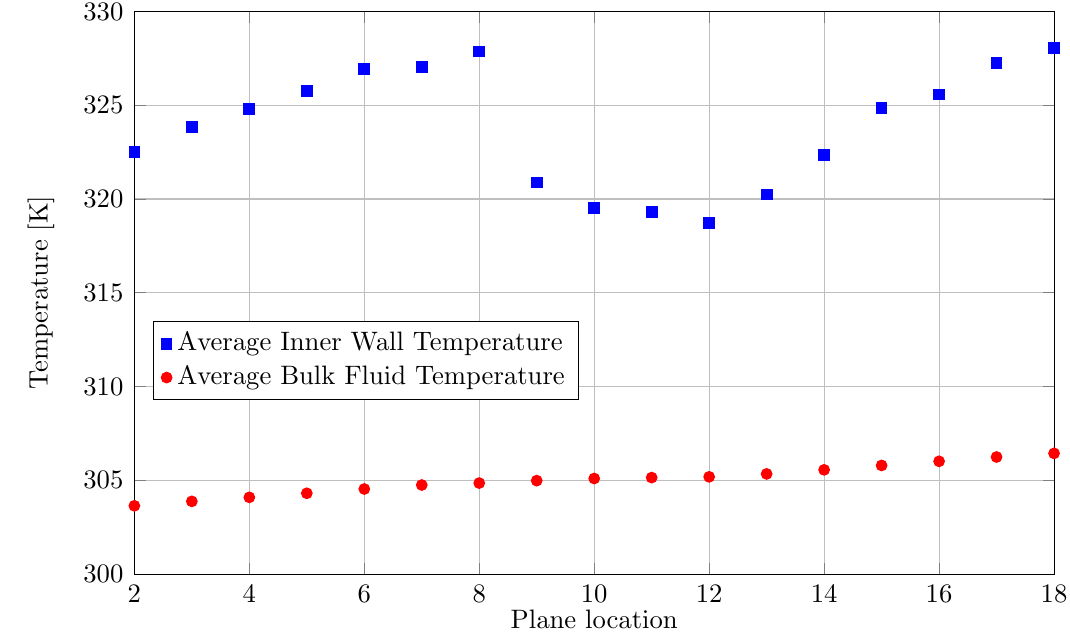
Figure 16. Wall and bulk fluid temperature at each plane location using fruit